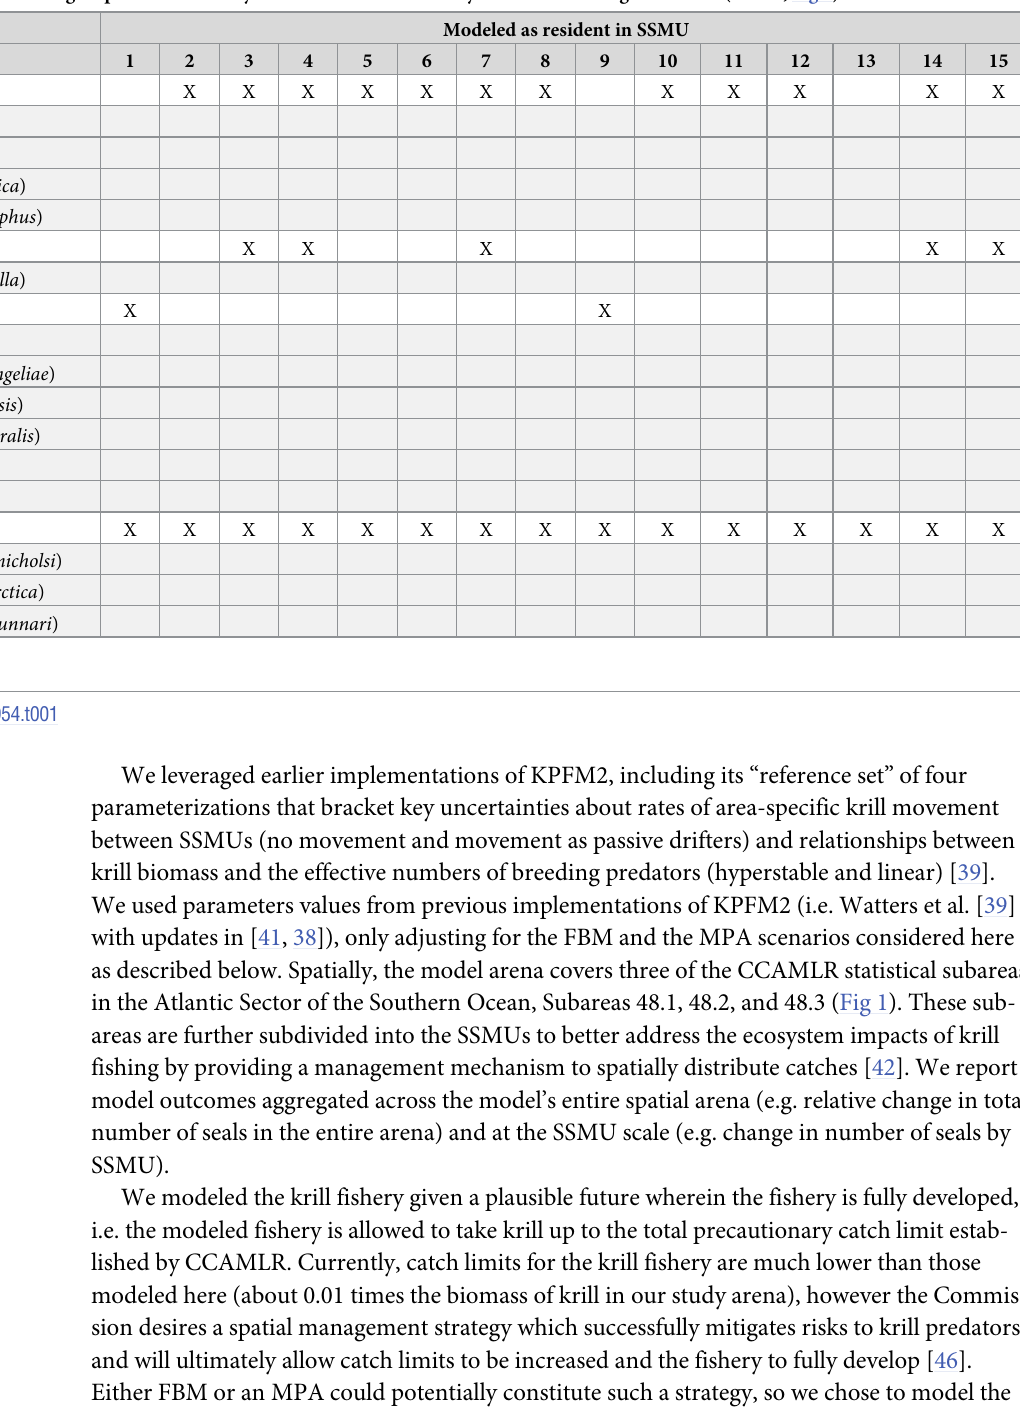
Table 1. Species composition of krill predator groups and where they are modeled as resident by small scale management unit (SSMU, Fig 1). Predator group